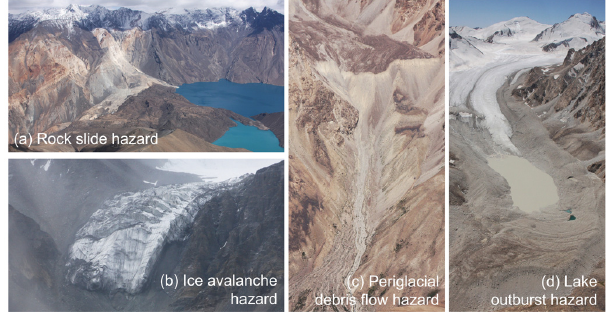
Fig. 1. Processes covered by the high-mountain multi-hazard and -risk indicator model. (a) The 2 km 2 rock slide deposit impound- ing Lake Sarez, triggered by an earthquake in 1911, (b) hang- ing glacier in the Sauksay Valley prone to produce ice avalanches, (c) periglacial debris flow starting from a rock glacier terminus in the upper Gunt Valley, (d) Lake Varshedz in a southern tributary of the Gunt Valley, one of many glacial lakes possibly susceptible to sudden drainage. All photos taken by M. Mergili.